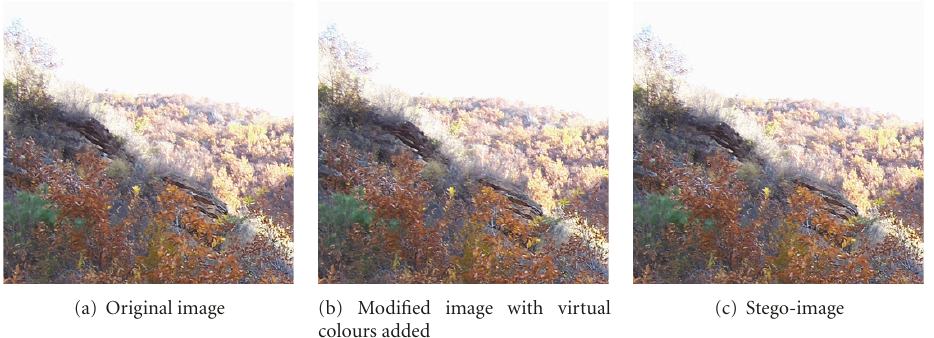
Figure 7: PEC-based data hiding experiments on image “Hill.”